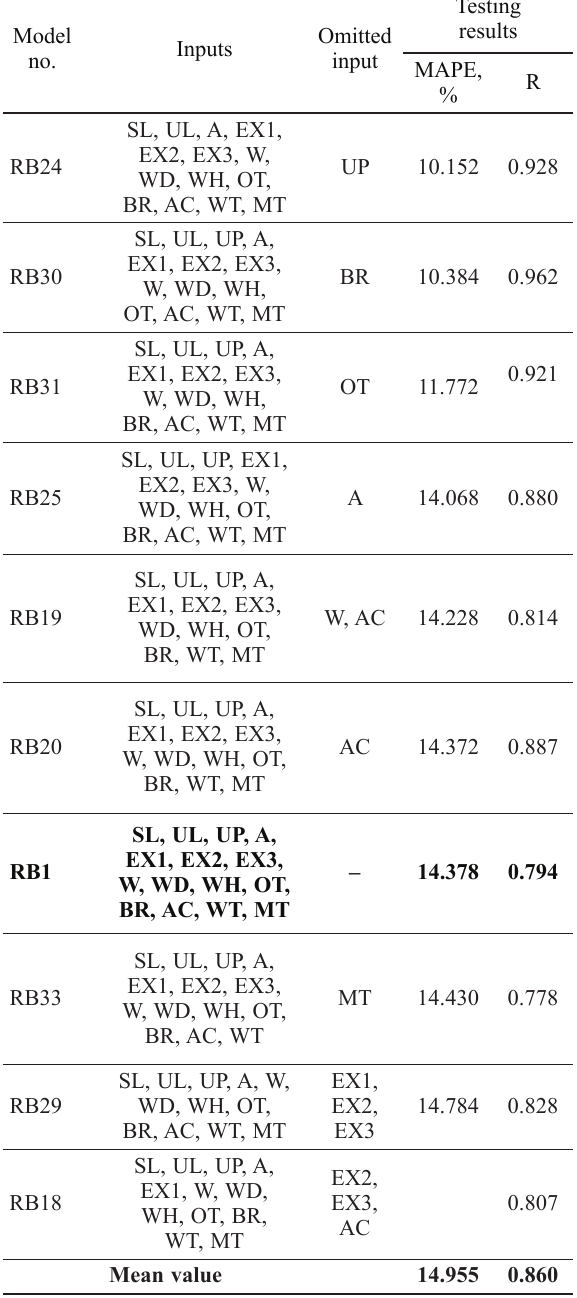
Table 3. Productivity modeling results for RBNN Model